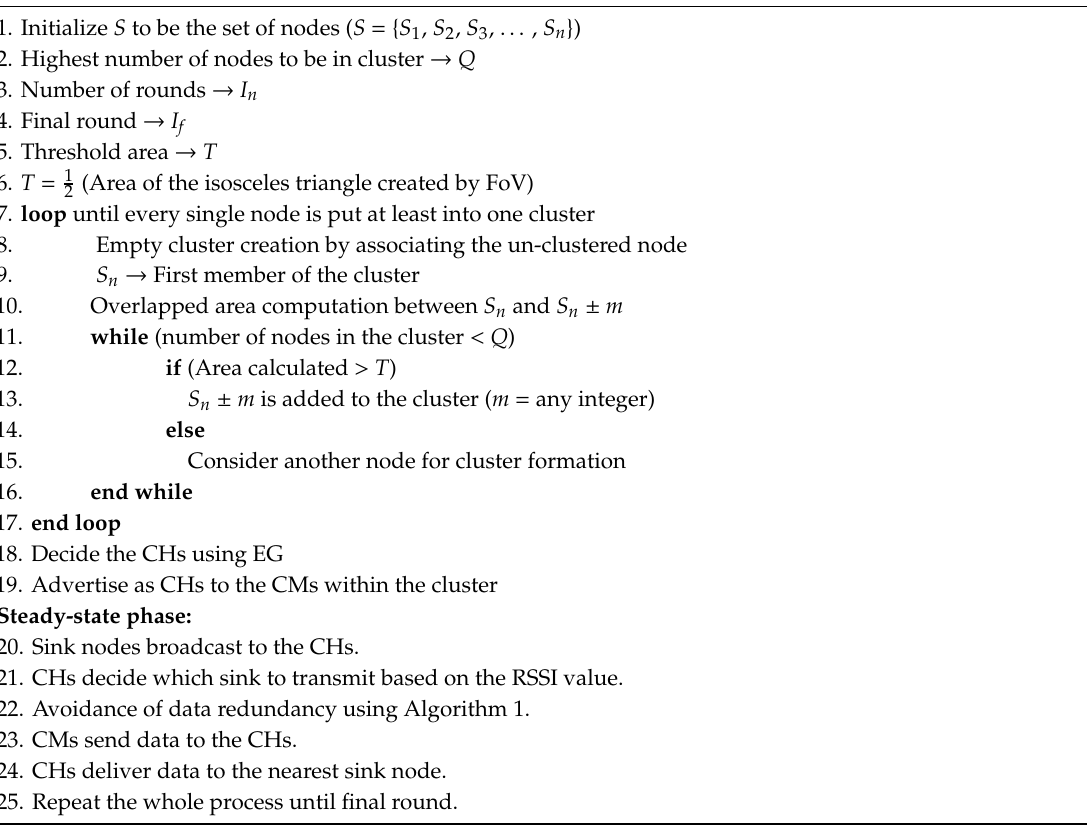
Algorithm 2 Routing